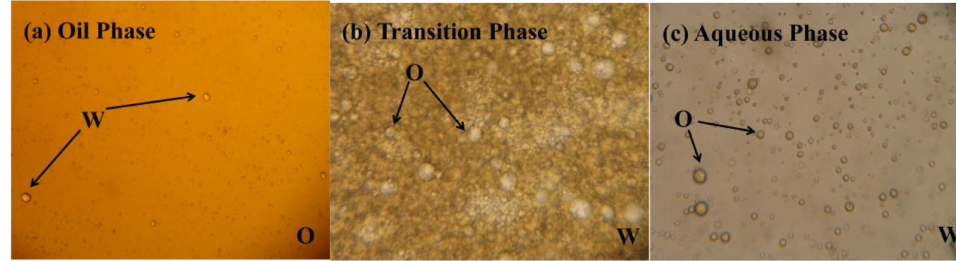
Figure 2. Morphological images of oil-water